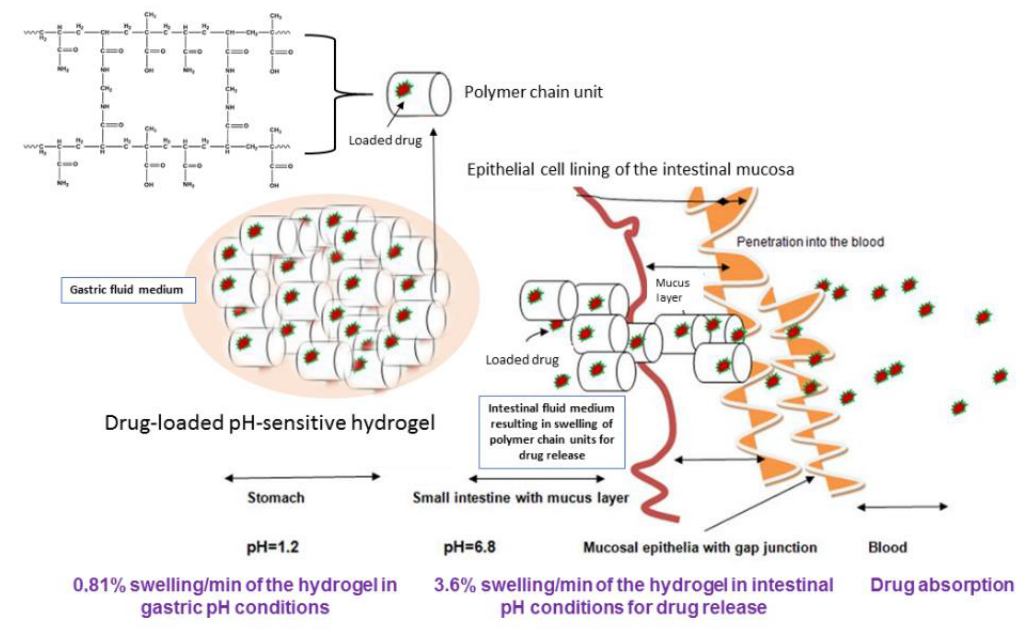
Figure 5. Mechanism of pH-responsive hydrogel system